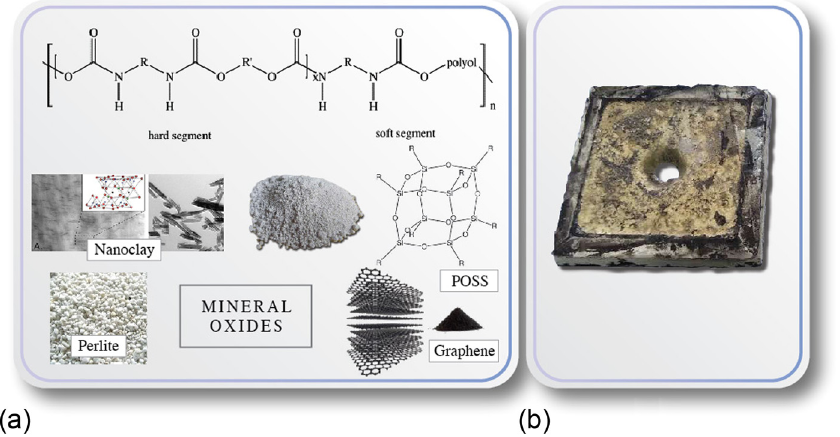
Figure 7: ( a ) PU – EHSM and most common reinforcements utilized in them. ( b ) PU – EHSM with titanium dioxide as reinforcement after the oxyacetylene test ( ref. 57 )